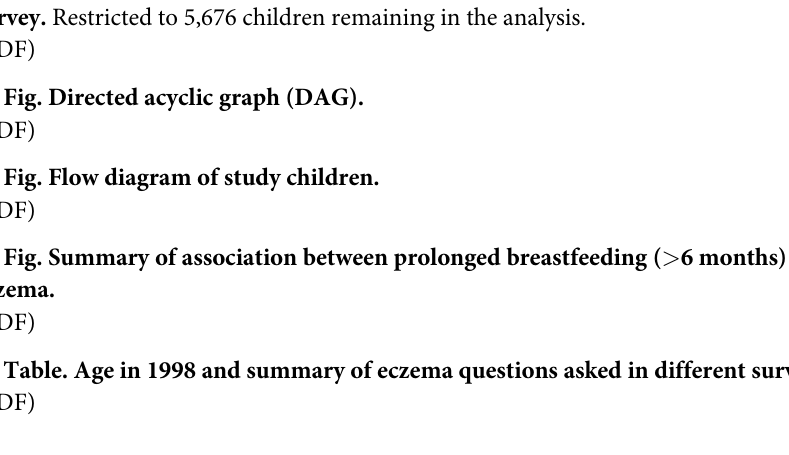
S1 Fig. Age range of children from Leicester Respiratory Cohorts who participated in each survey. Restricted to 5,676 children remaining in the analysis.